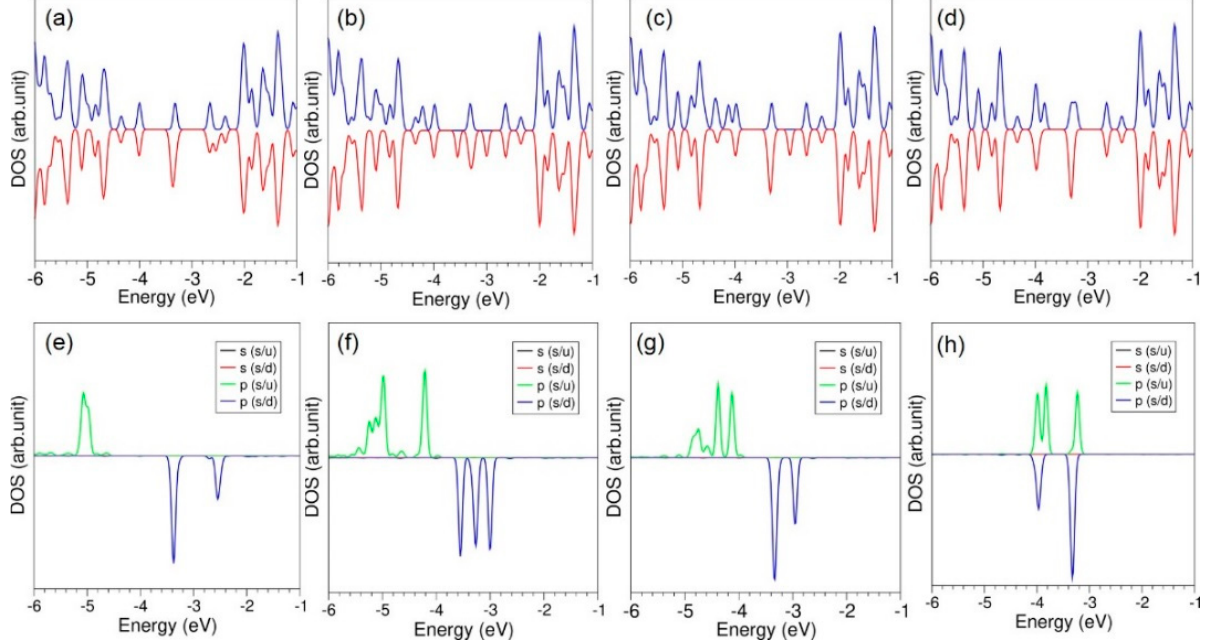
Figure 5. Total DOS plots of ( a ) O, ( b ) S, ( c ) Se and ( d ) Te adsorbed onto the graphene. Corresponding atomic DOS plots ( e – h ) are also shown.